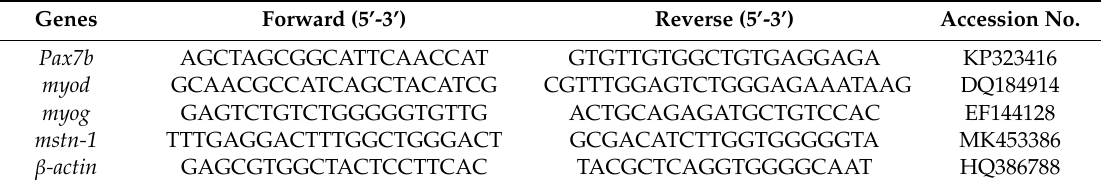
Table 2. List of PCR primer pairs used for the reverse-transcriptase PCR (RT-PCR) analysis.